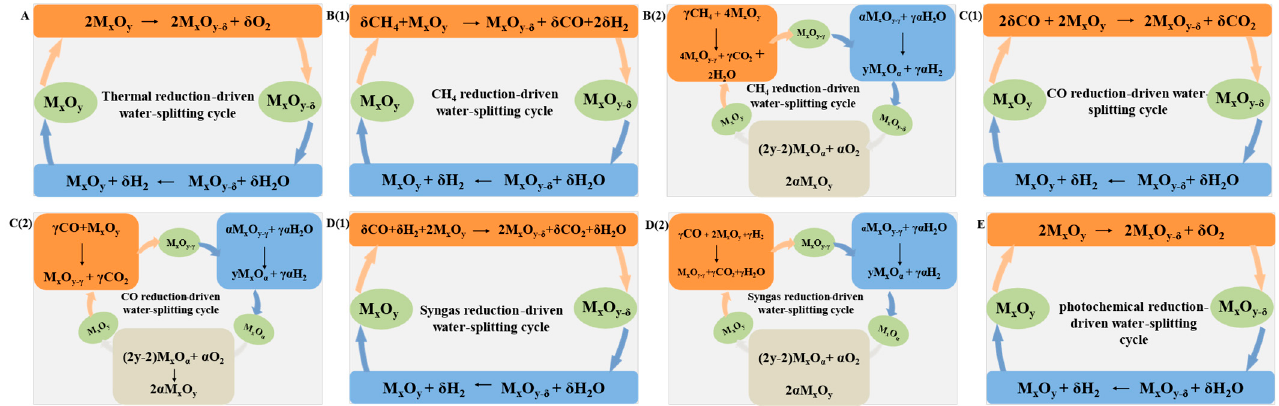
Figure 2. Chemical looping water-splitting process with various reducing methods: ( A ) two-step water-splitting thermochemical cycle, ( B ) methane chemical looping process, ( C ) chemical looping water gas shift process, ( D ) syngas chemical looping process, and ( E ) photo-thermochemical cycle.